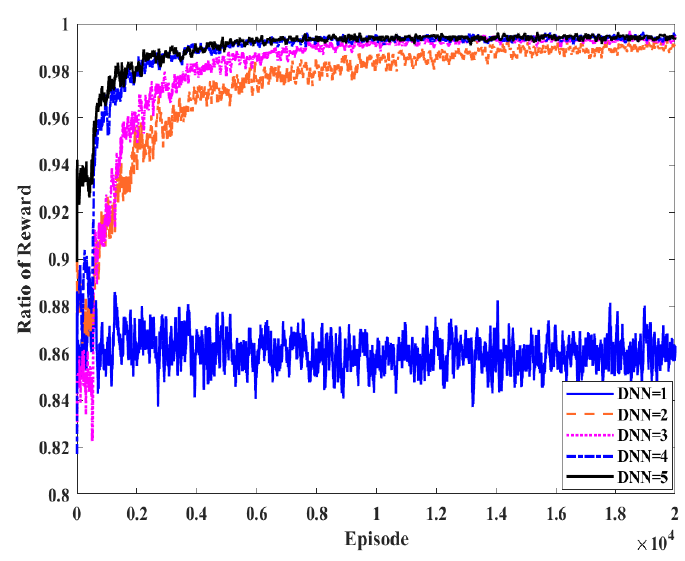
Figure 5. Convergence of performance over different number of DNNs.